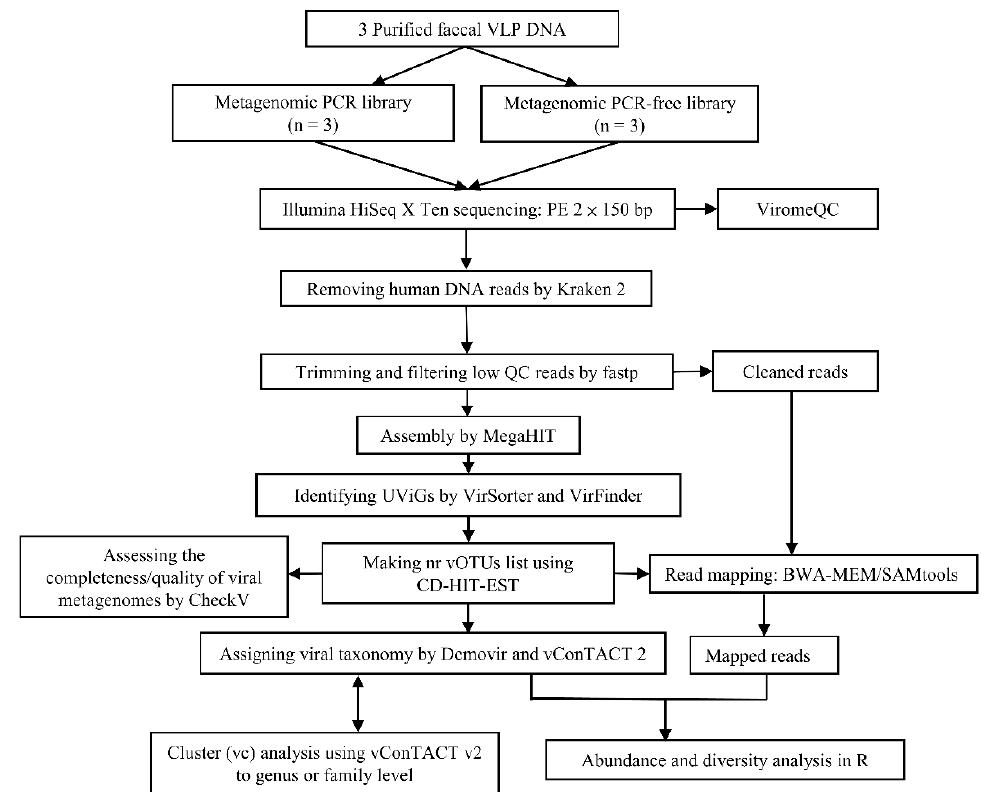
Figure 2. Overview of bioinformatic pipeline for cross-comparative virome study. Human DNA sequences identified by Kraken 2 against GRCh37 (Genome Reference Consortium; hg19) were removed, followed by trimming and filtering low quality reads using fastp prior to de novo assembly. MEGAHIT was used to assemble Illumina short reads into longer contigs, followed by detecting potential uncultivated viral genomes (UViGs) candidates using VirSorter and VirFinder. UViGs were used to generate a non-redundant database giving viral operational taxonomic units (vOTUs) which would represent the largest of many UViGs at 95% identity. BWA/SAMtools were then used for read-mapping, followed by analysing mapped viral reads and visualising the outcome of PCR and PCR-free datasets in relative abundance and alpha and beta diversity. In parallel, the qualities of both pooled non-redundant viral contigs from PCR and PCR-free datasets were assessed using CheckV, respectively. Moreover, DemoVir was used to assign taxonomy to these viral contigs, followed by performing cluster analysis to compare vOTU similarity between both datasets using vConTACT